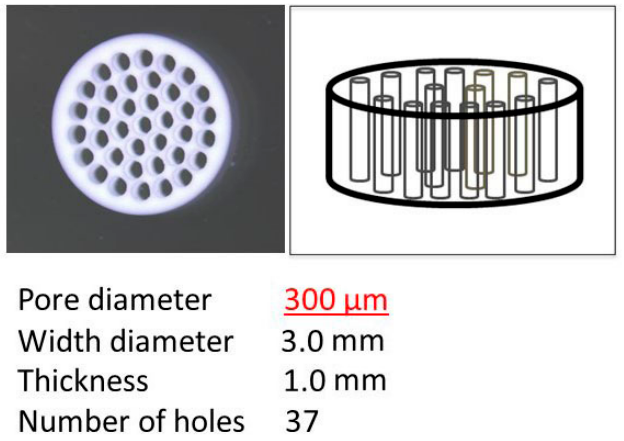
Figure 1. The honeycomb TCP used in the transplant experiment.